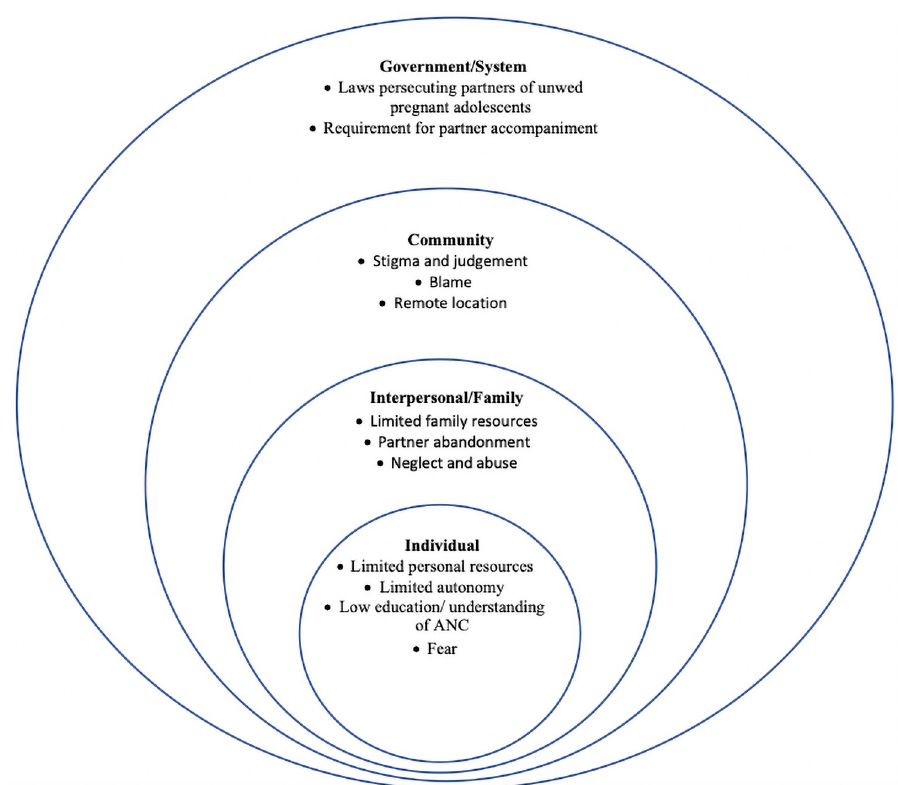
Fig 1. Barriers and enablers categorized within the social ecological